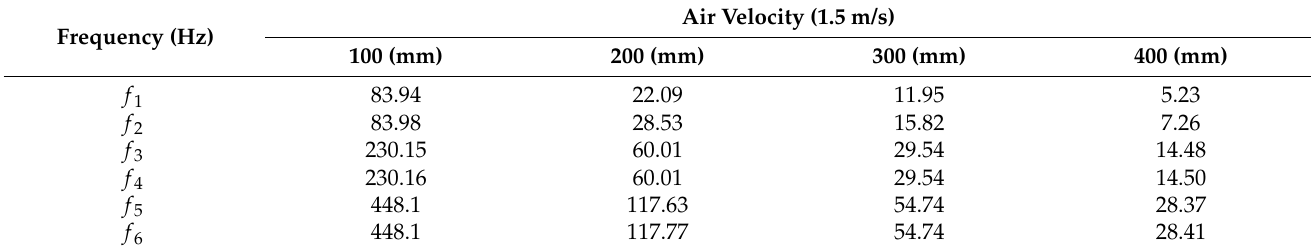
Table 4. The first 6-order natural frequencies with different fiber lengths at air velocity 1.5